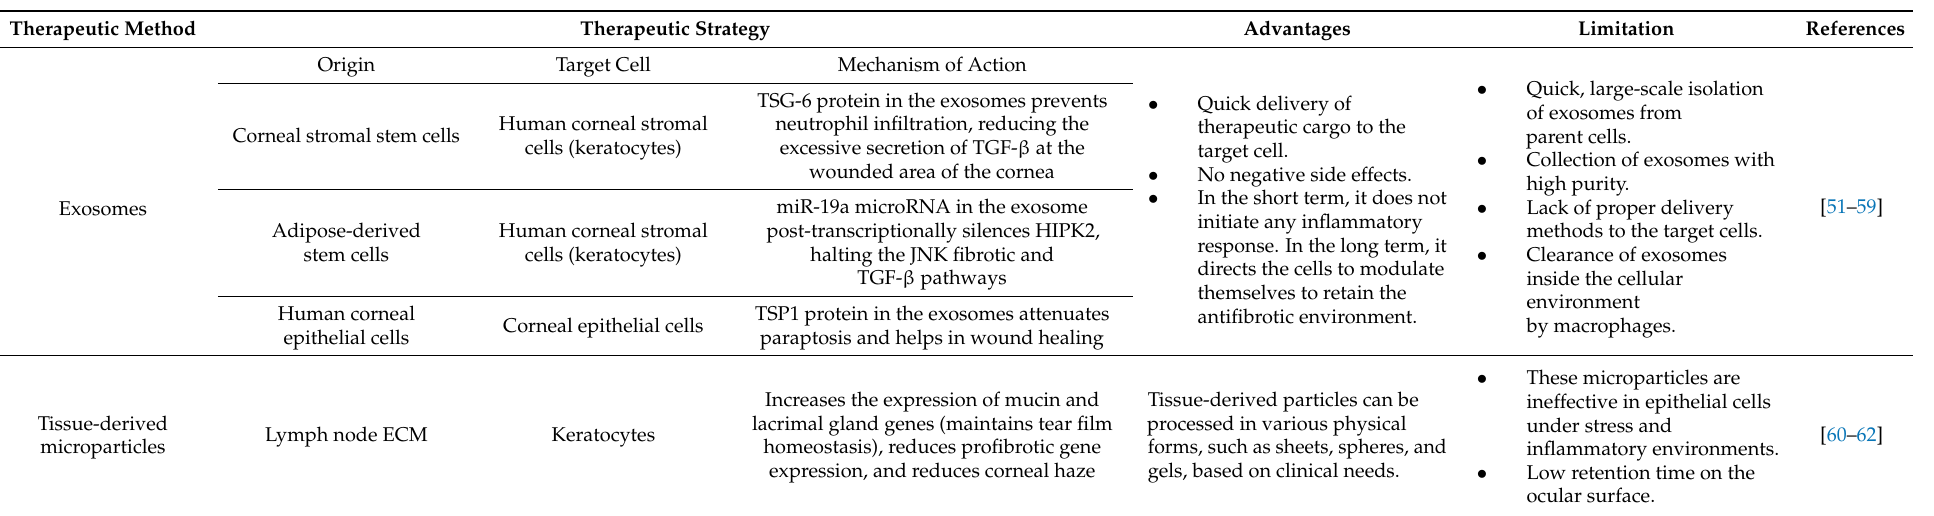
Table 1. Exosomes as therapeutic tools in reviving a cornea without